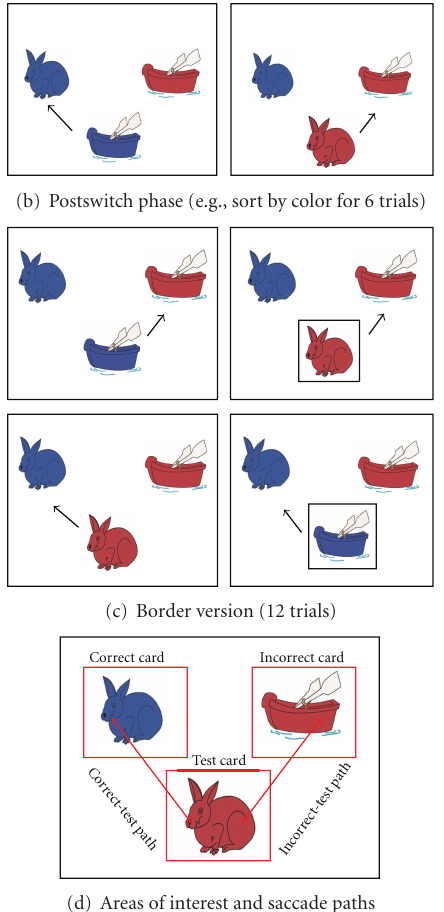
Figure 1: Illustration of trials in the preswitch phase (a), postswitch phase (b), and the border version (c), and examples of areas of interest (AOI) and saccade paths (d). Upper cards were targets and the bottom card was the test card. Arrows show correct sorts (pictures from